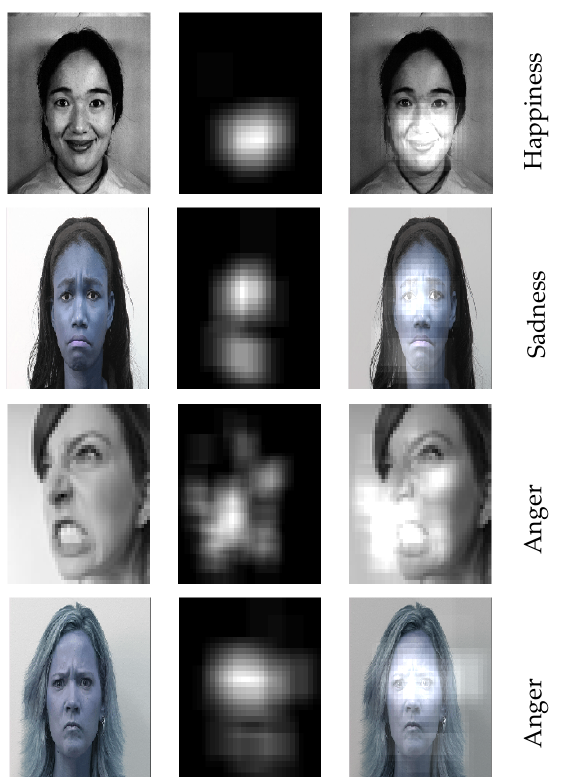
Figure 1. The detected salient regions for different facial expressions using our model. The images in the first and third rows are taken from the FER dataset, and the images in the second and fourth rows belong to the extended Cohn-Kanade